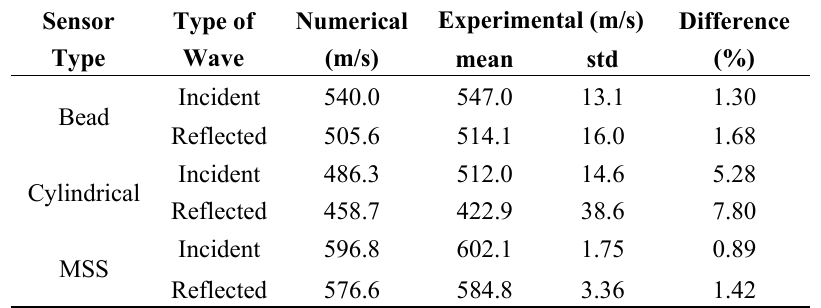
Table 3. Experimental and numerical speed of the incident and reflected HNSW